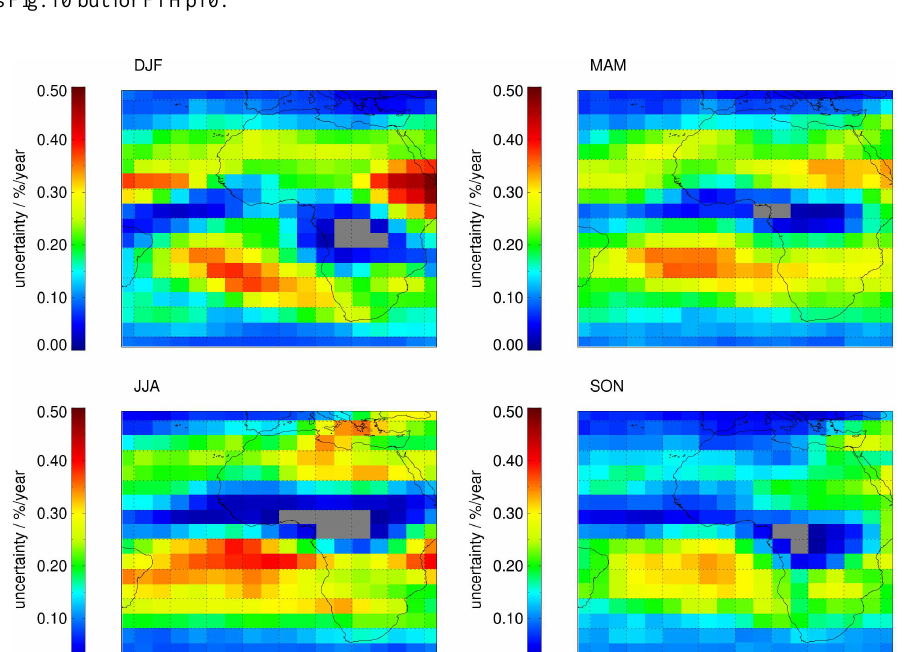
Figure 12. Same as Fig. 10 but for FTHp10.